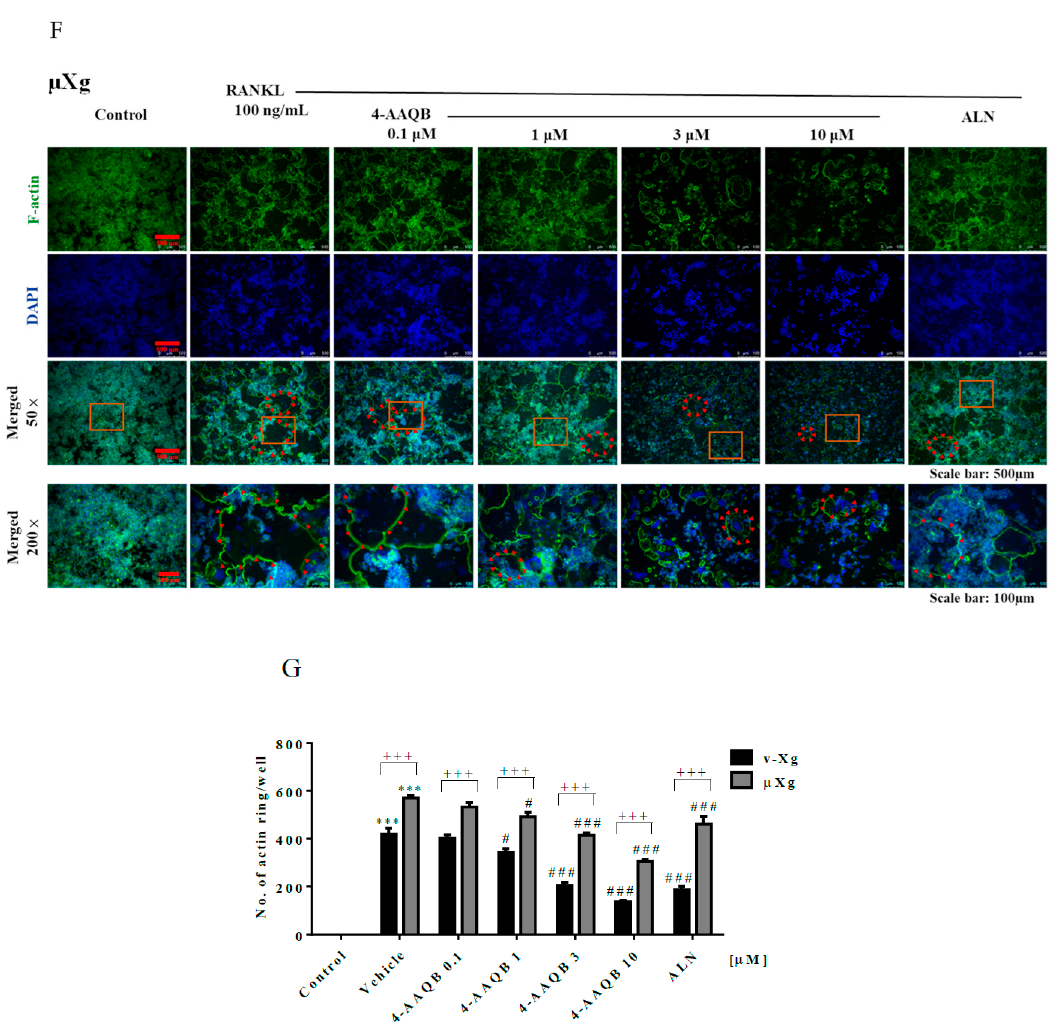
Figure 2. 4-AAQB attenuation of osteoclast formation after v-Xg and µ Xg stimulation. After exposure in v-Xg ( A ) or µ Xg ( B ) for 24 h, and the cells were treated with 4-AAQB (0.1, 1, 3, or 10 µ M) or ALN (10 µ M) combined with RANKL for 72 h. The quantitative results of the number of TRAP ( + ) osteoclasts / well ( C ) and area of TRAP ( + ) osteoclasts (%) ( D ) represent the mean ± SEM ( n = 6). In addition, fluorescent staining (actin ring and DAPI; ( E , F )) and quantitative results (number of actin rings / well; ( G )) were conducted. Osteoclasts or actin rings are indicated by red arrows. Orange rectangles represent the areas magnified 200 times. *** p < 0.001 versus control; # p < 0.05, ## p < 0.01, and ### p < 0.001 versus RANKL; ++ p < 0.01 and +++ p < 0.001 versus v-Xg.